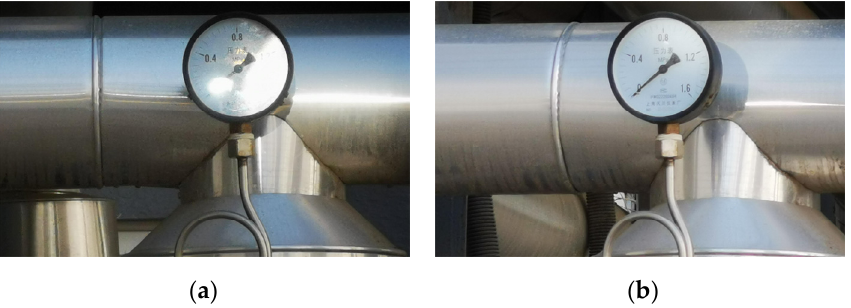
Figure 20. Comparison of light reflection adjustment; ( a ) image without removing light reflection; ( b ) image after removing light reflection.